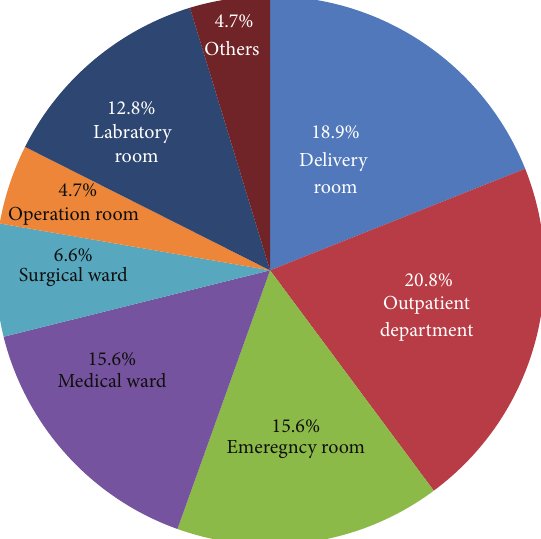
Figure 5: The percentage of working room of healthcare workers of the last 12 months in the selected health institutions, 2014.